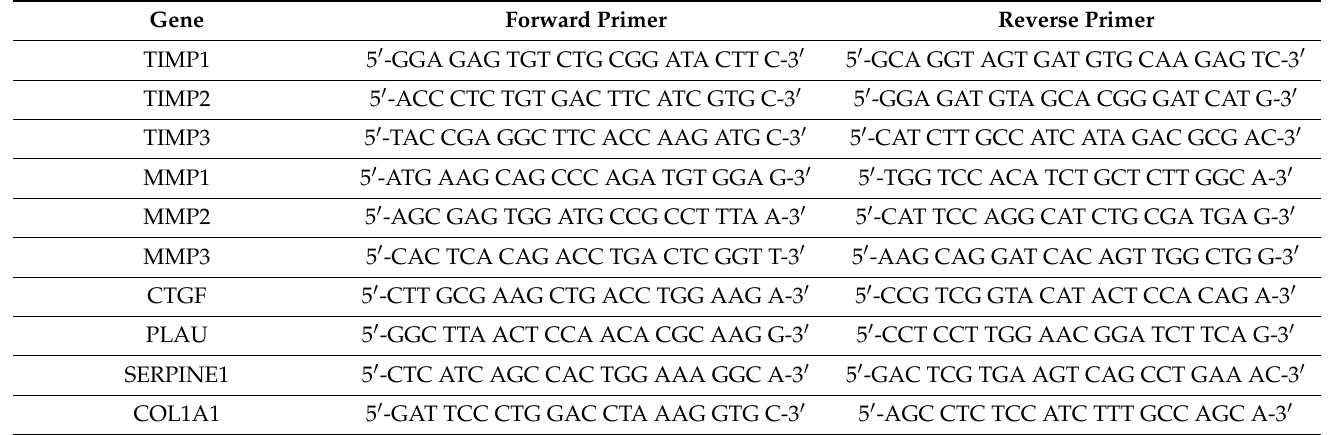
Table 1. List of